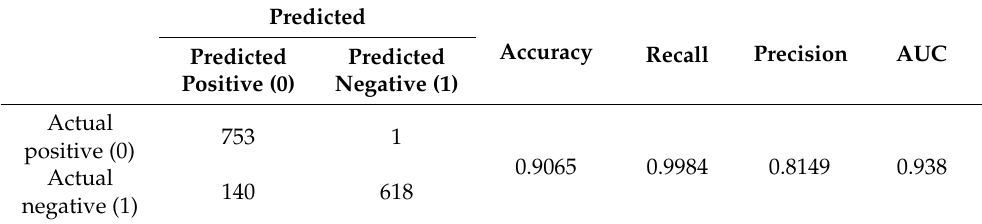
Table 6. LR confusion matrix before